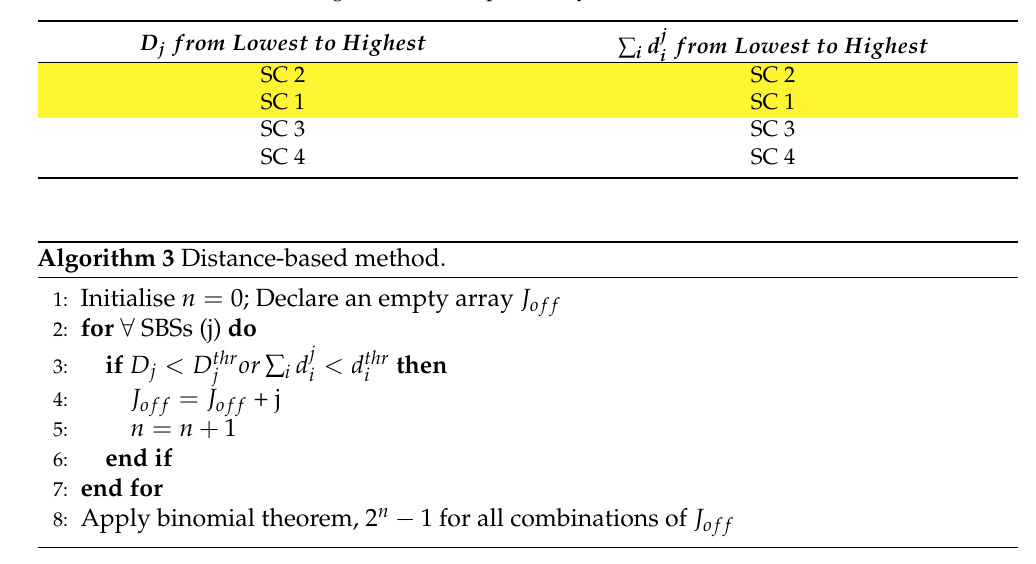
Table 3. SBSs ordered from highest to lowest possibility to be switched off.